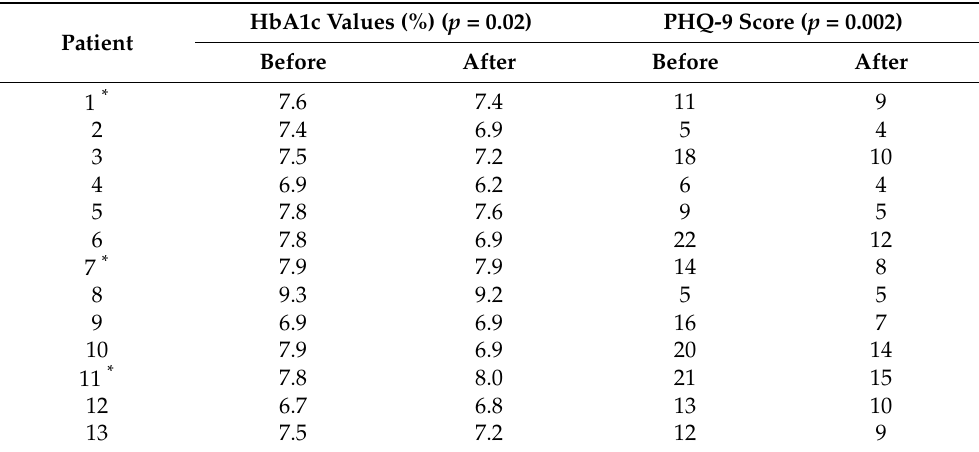
Table 2. Level of glycosylated hemoglobin and PHQ-9 for each patient before and after using the virtual assistant.